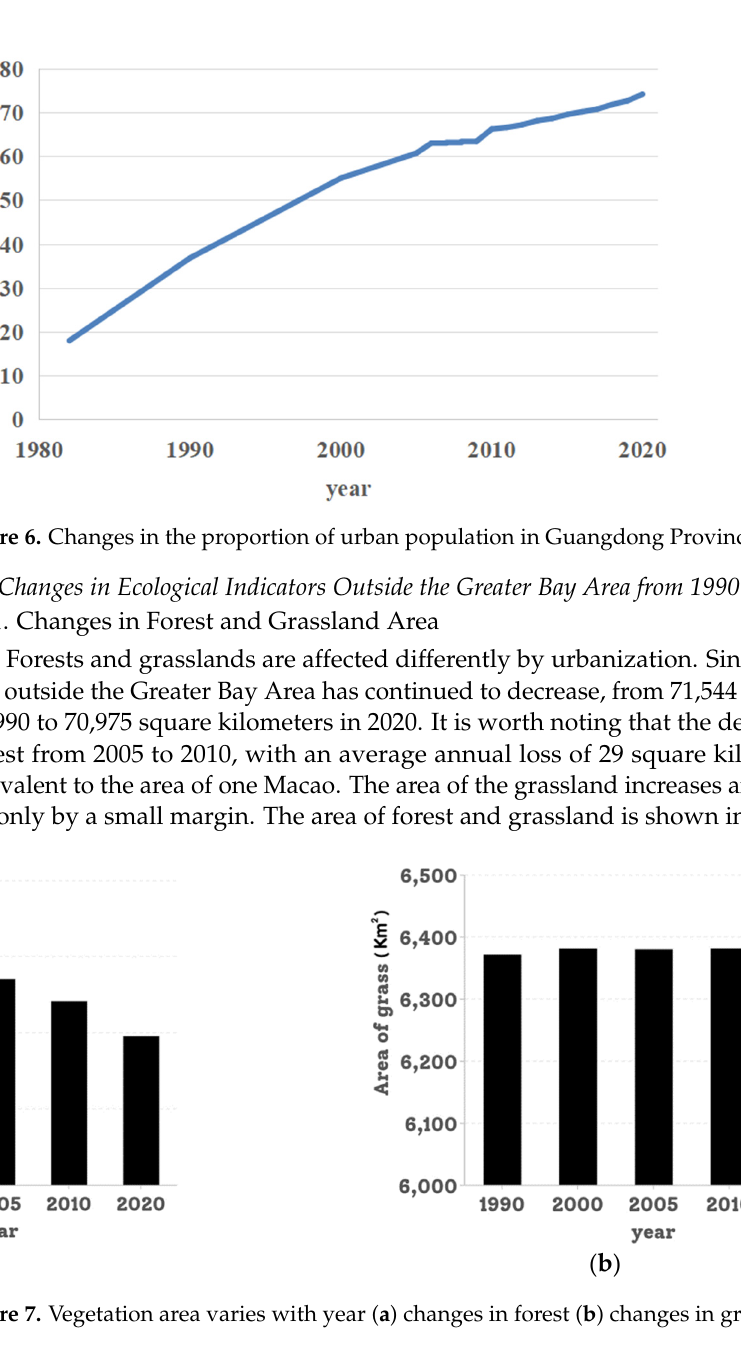
Figure 7. Vegetation area varies with year ( a ) changes in forest ( b ) changes in grass.